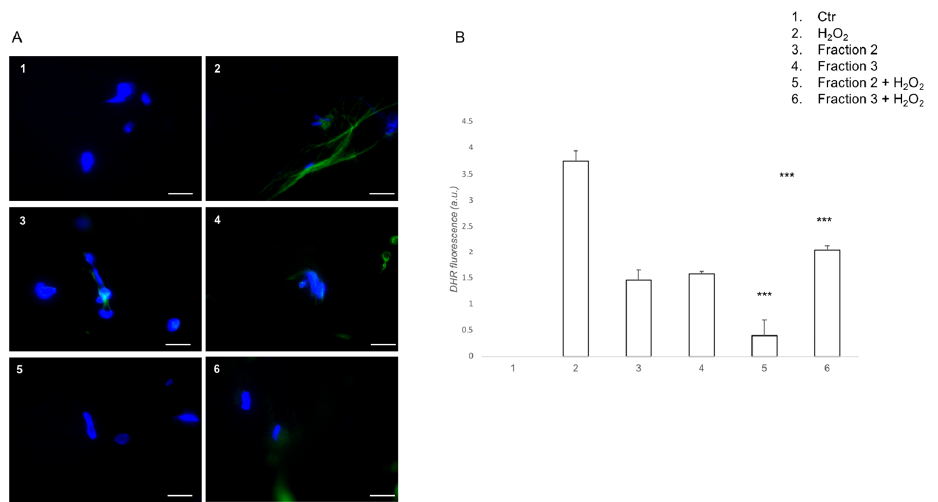
Figure 3. Soybean peptides prevents H 2 O 2 -induced, intracellular ROS formation. ( A ) DHR-loaded cells were pre-treated for 1 h with peptide fractions 2 or 3 (1 mg mL − 1 ), then incubated for further 30 min with H 2 O 2 (1 mmol L − 1 ), and finally observed and analyzed with a fluorescence microscope (scale bar: 100 µ m); ( B ) Quantification of the mean fluorescence of individual cells. Results are expressed as arbitrary units and represent the average ± SD calculated from three independent experiments, each performed in duplicate. Statistical analysis was performed with ANOVA followed by Bonferroni’s test. *** p < 0.001, comparing 5 with 2 or 6 and 6 with